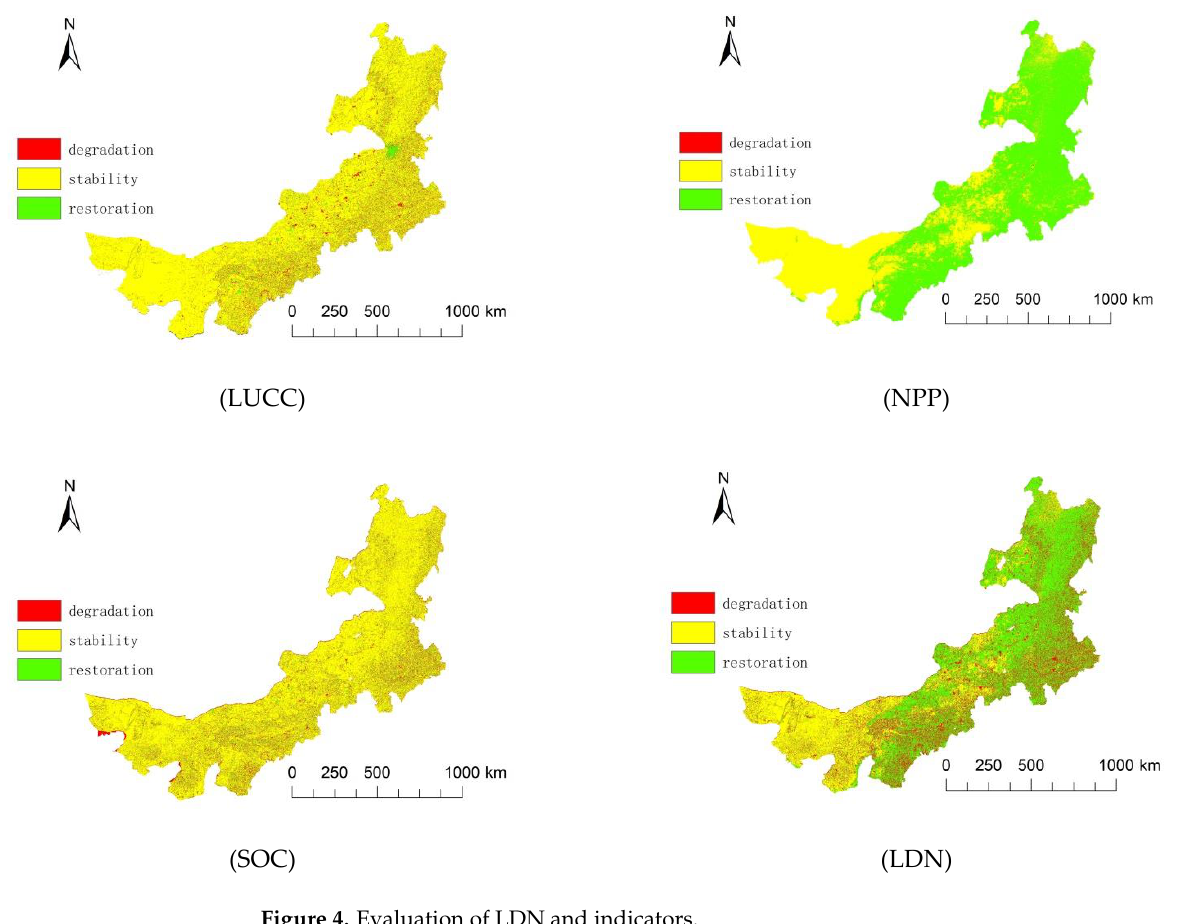
Figure 4. Evaluation of LDN and indicators.